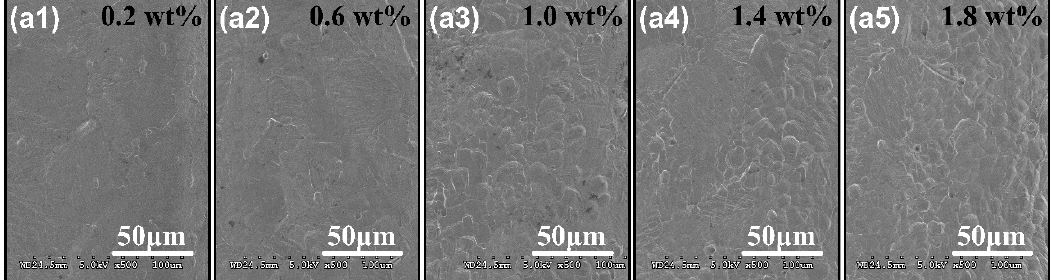
Figure 8. SEM images of the surface quality on the bottom of the micro-grooves with the electrolyte concentrations of ( a1 ) 0.2 wt%, ( a2 ) 0.6 wt%, ( a3 ) 1.0 wt%, ( a4 ) 1.4 wt% and ( a5 ) 1.8 wt% accordingly.